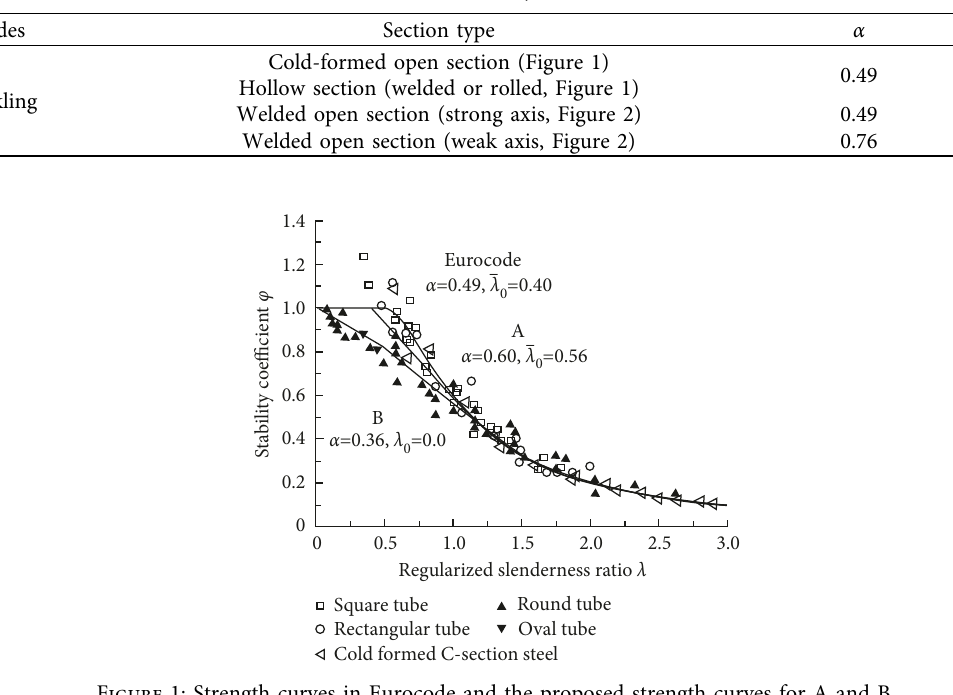
Table 3: Parameters for Perry method in